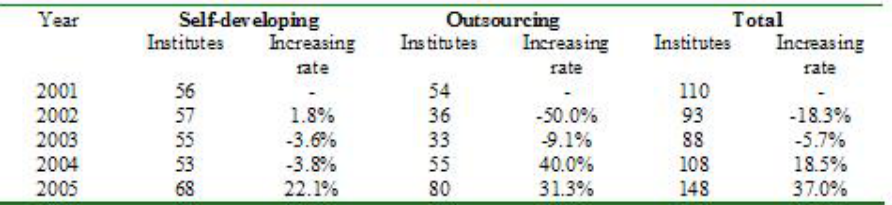
Uniformity and controlled